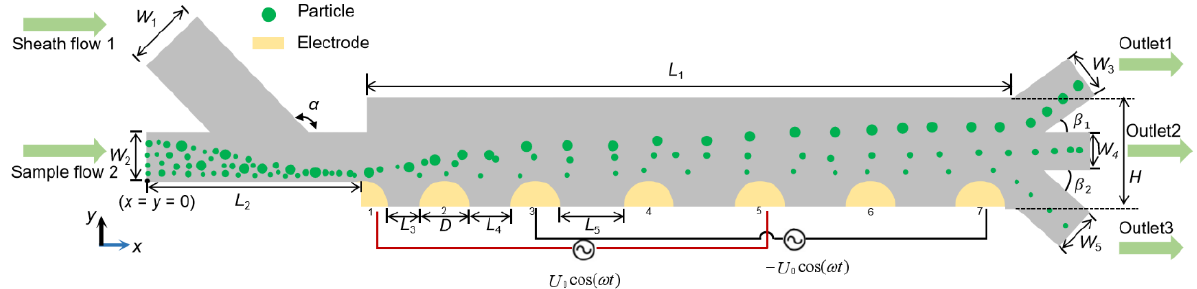
Figure 1. The layout of the hybrid floating cIDE separator (not drawn to scale). Table 1. Specification of characteristic dimensions of the separator.